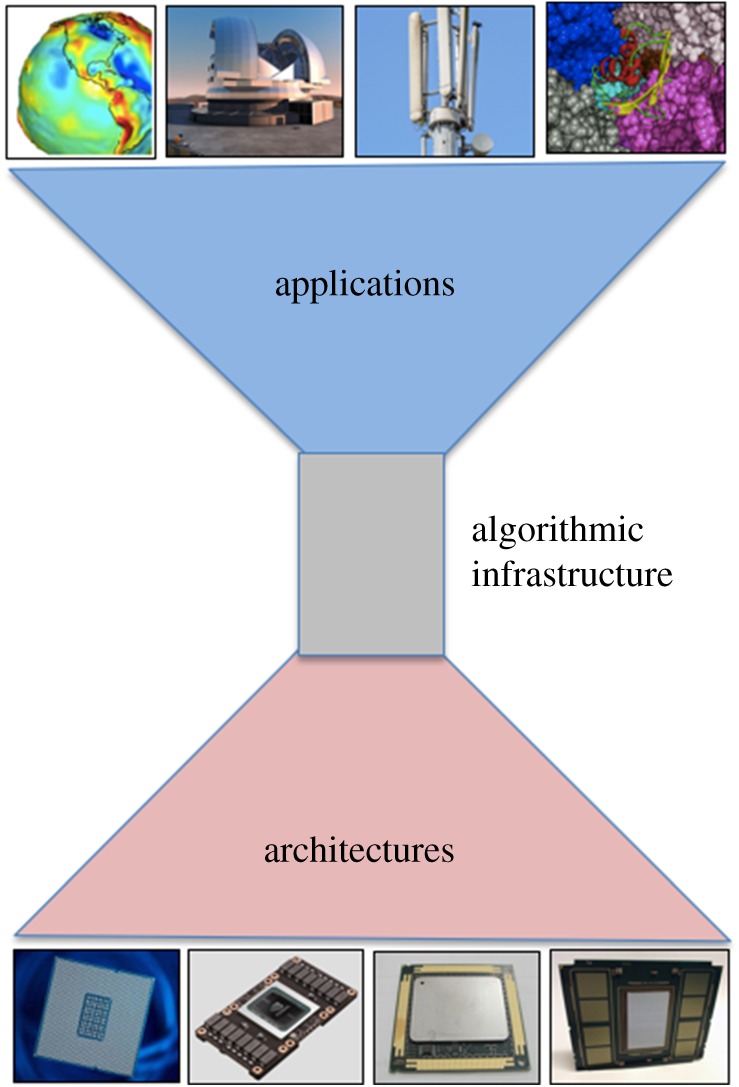
Hourglass model.